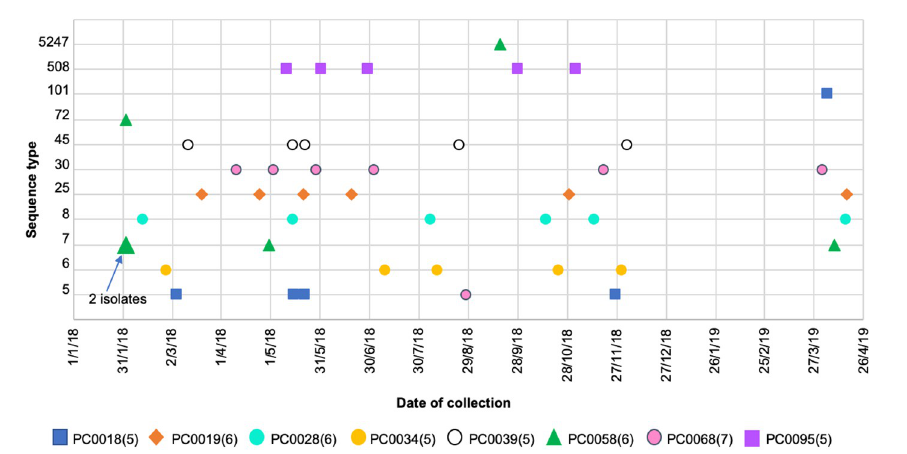
Fig 4. Colonising sequence types from patients with five or more isolates